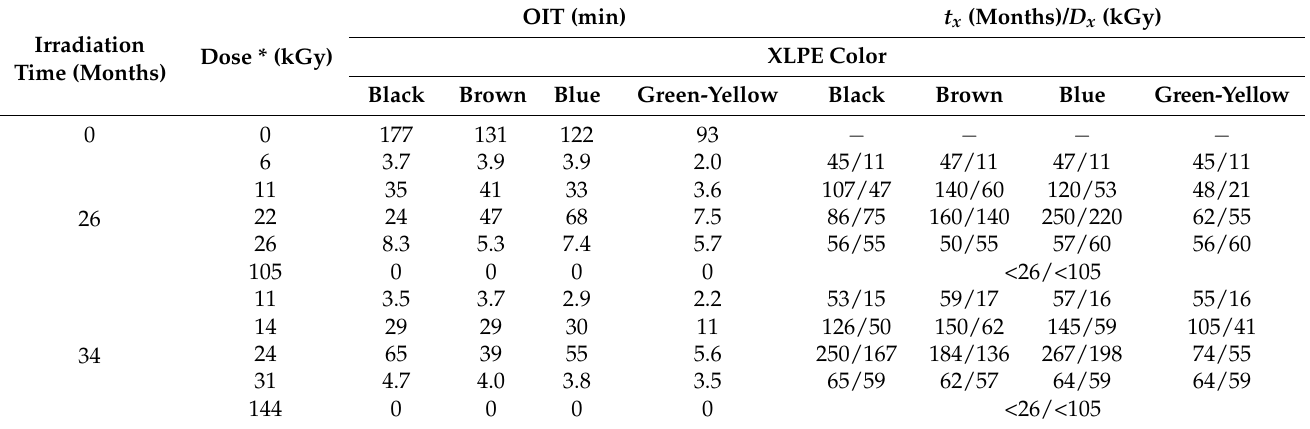
Table 2. Degradation model parameters and lifetime evaluation of XLPE insulation of IC1 cable (different colored multi conductors; Figure S5) irradiated in the CERN-SPS accelerator (isothermal DSC measurements, T = 200 ◦ C,